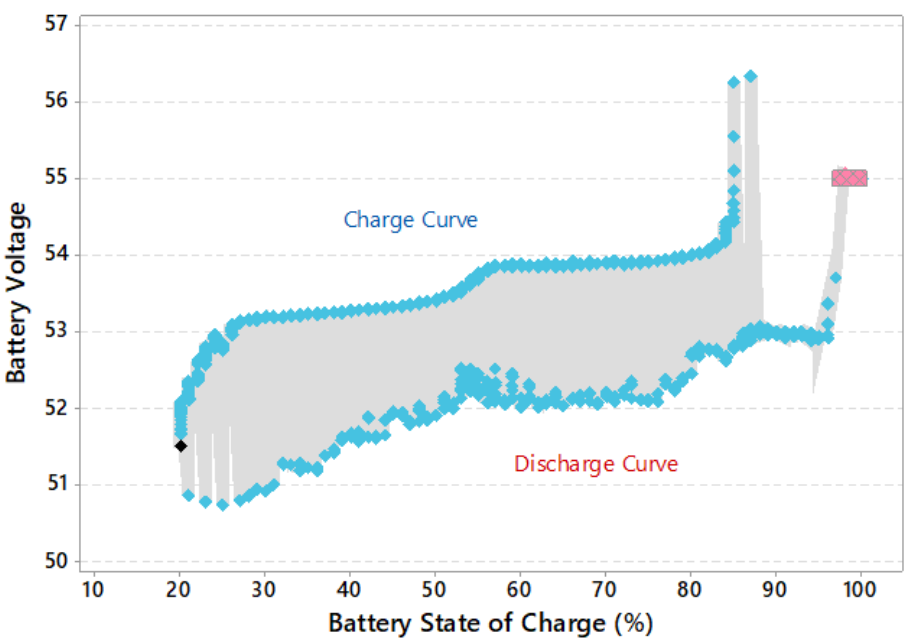
Figure 13. Storage system voltage discharging/charging cycle. By making a correlation between the voltage, the charge status and the power deliv- ered by the battery, through Figure 14a,b, it can be verified that when SoC < 55% and the power > 12.5 kW, lower voltage levels in the discharge process are observed, as presented in Figure 14a. However, during the charging process, a constant voltage is observed in Figure 14b. The main difference between the charge and discharge diagrams for the storage system, observed in Figures 14 and 15, is that the charge process is constant, at a C-rate of 0.035 (75 A), while the second depends on the demand of the building loads, varying throughout the day.